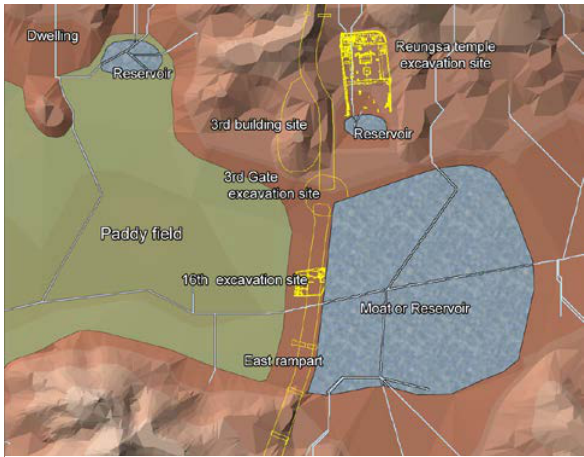
Figure 8. An example of the new hypothesis deducted from comparative analysis between the restored topography and the existing ruins continuous water from the reservoir outside the western bank.